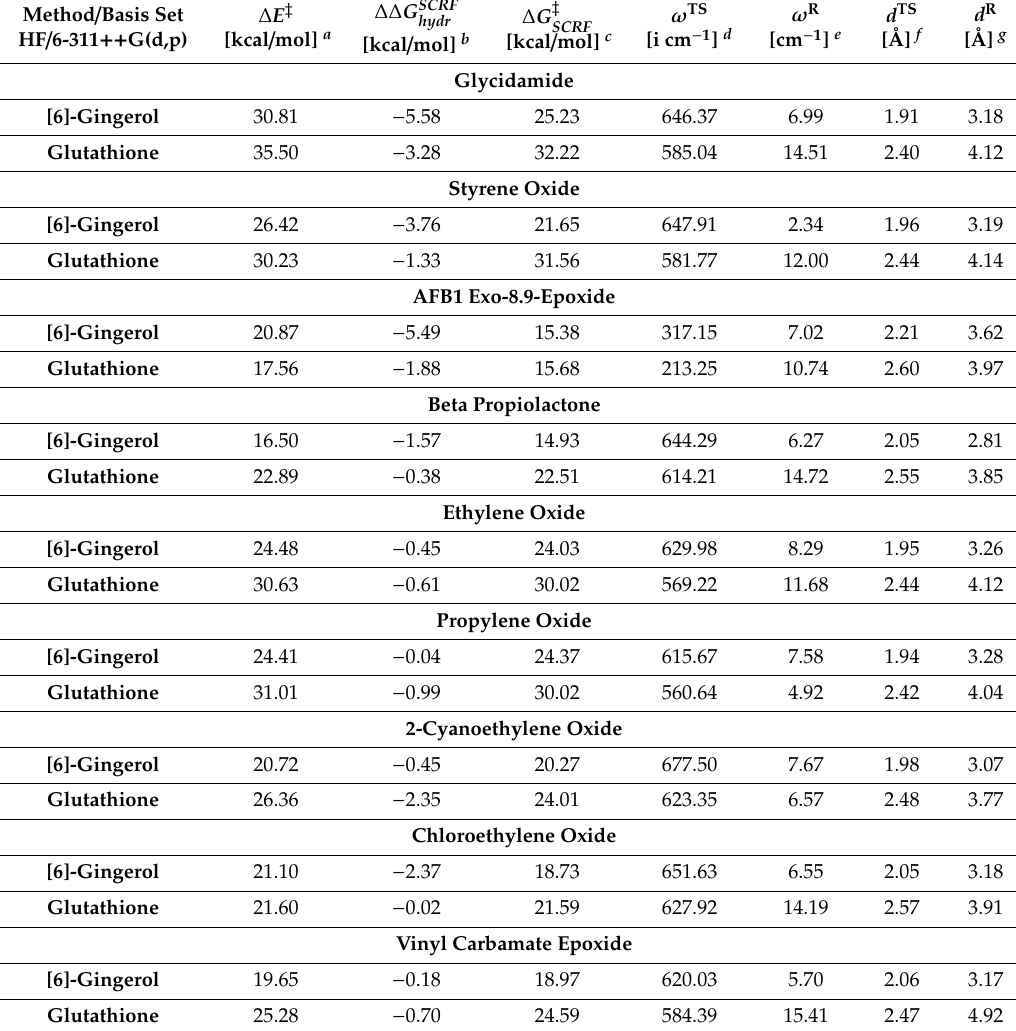
Table 1. The comparison of activation free energies for the reactions between nine studied ultimate chemical carcinogens and [6]-gingerol as well as glutathione at the HF / 6-311 ++ G(d,p) level of theory. Method / Basis